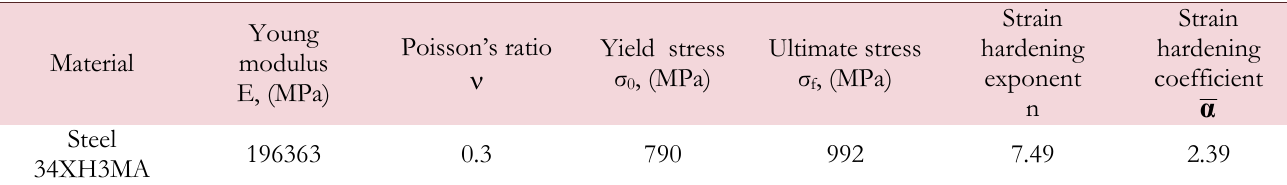
Table 1: Main mechanical